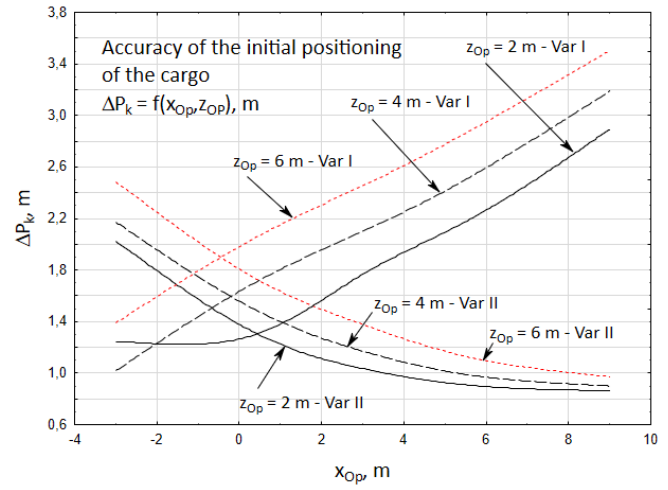
Figure 12. Accuracy of the initial positioning of the cargo ∆ P k , for two cases of the cargo handling task. As the operator moves away along the x axis, the accuracy of the cargo positioning increases for the second case. It is easier for the operator to estimate the length of the retraction of the telescopic boom (higher accuracy of the unidirectional linear